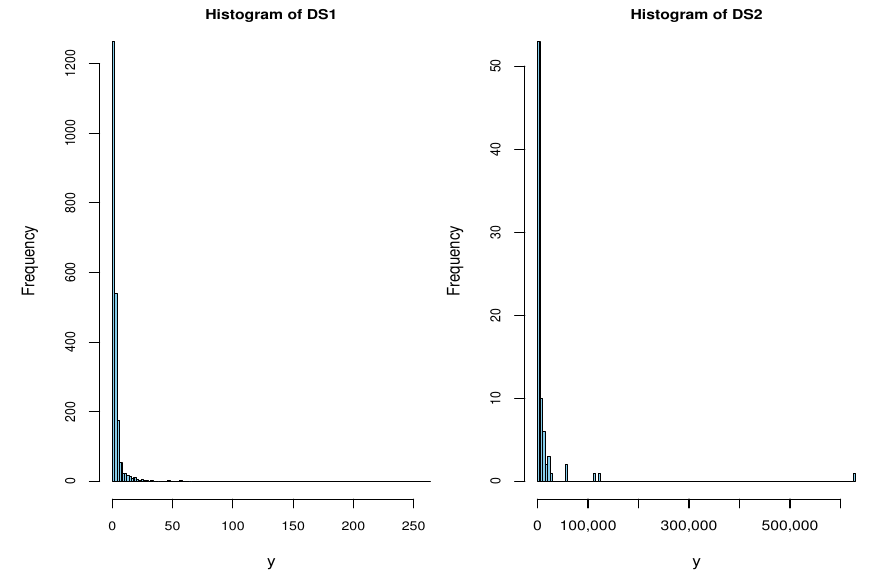
Figure 3. Data histograms corresponding to DS1 and DS2 datasetes.